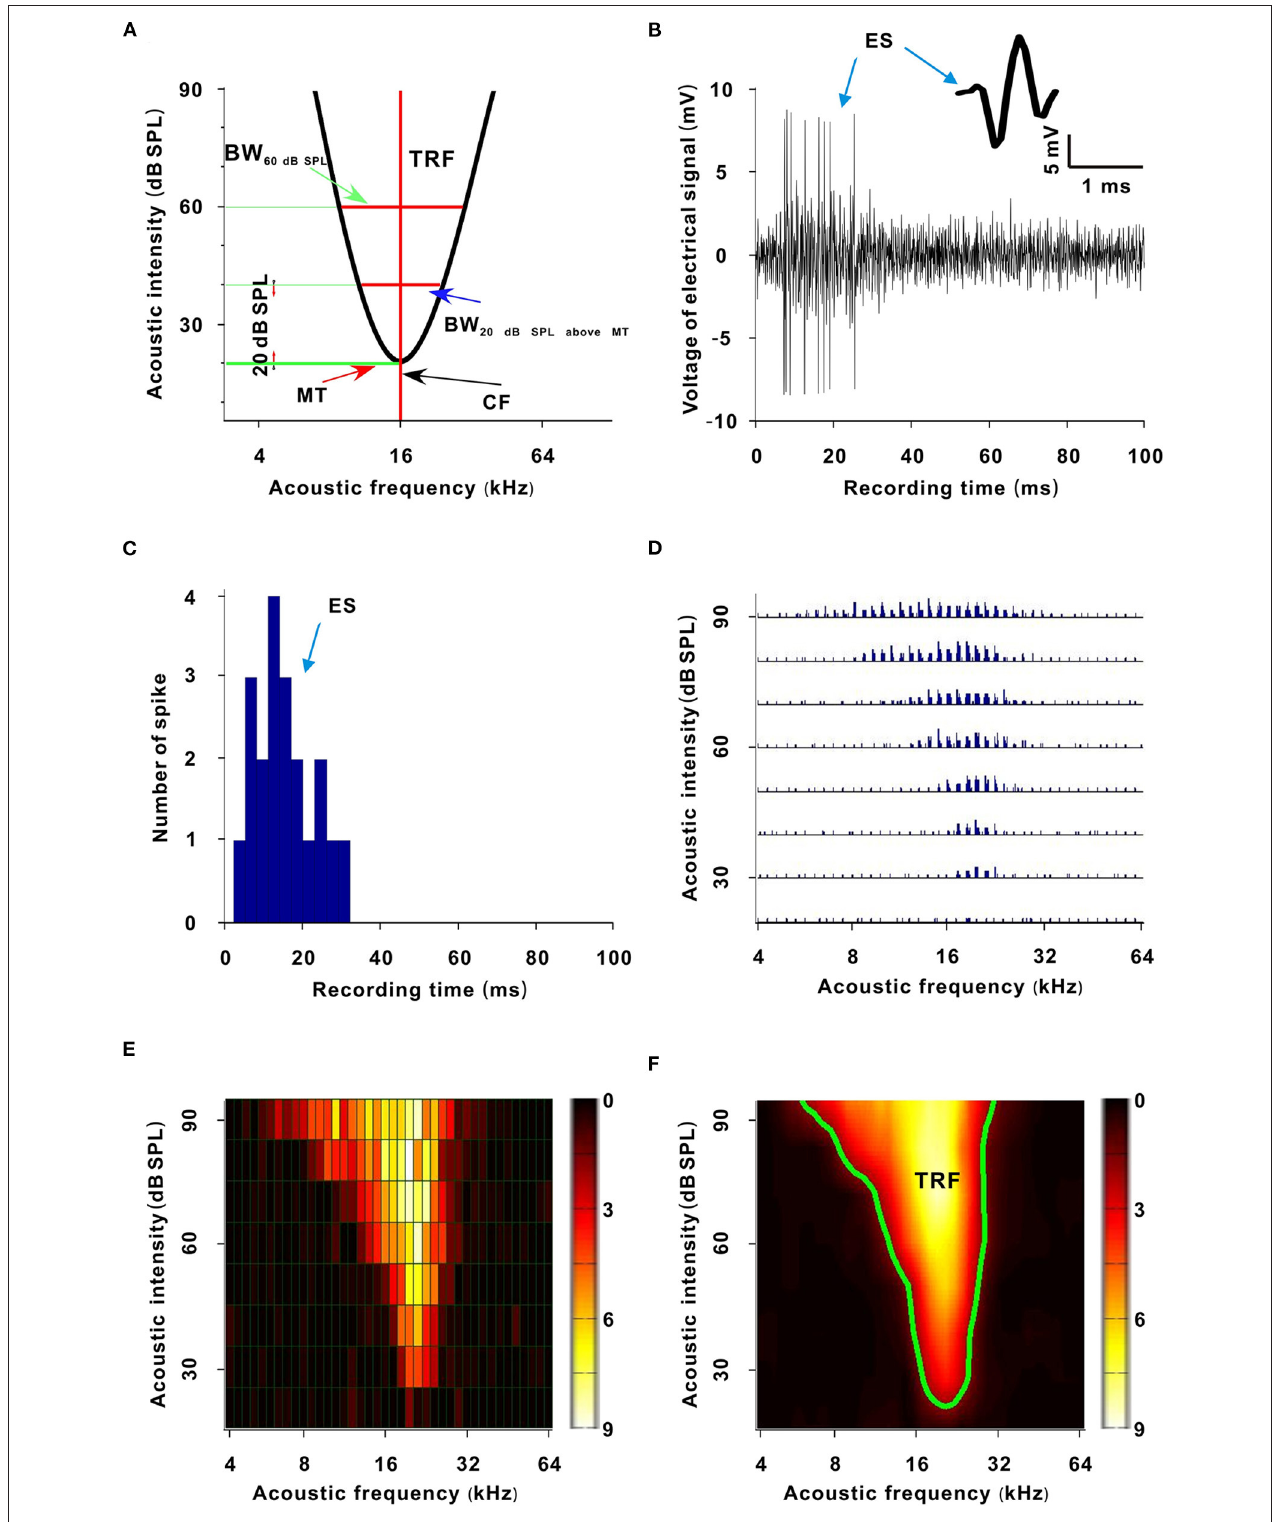
FIGURE 1 | Sketch map and generative process of the TRF. (A) Sketch map of the TRF. The abscissa is acoustic frequency and the ordinate is acoustic intensity (the same meaning in (D–F) and Figures 2 , 4 , 6 ). The area enveloped by the black curve is the TRF. The acoustic intensity corresponding to the bottom green transverse line is the MT. The acoustic frequency corresponding to the red vertical line is the CF. The width of the upper red transverse line is the BW 60 dB SPL . The width of the